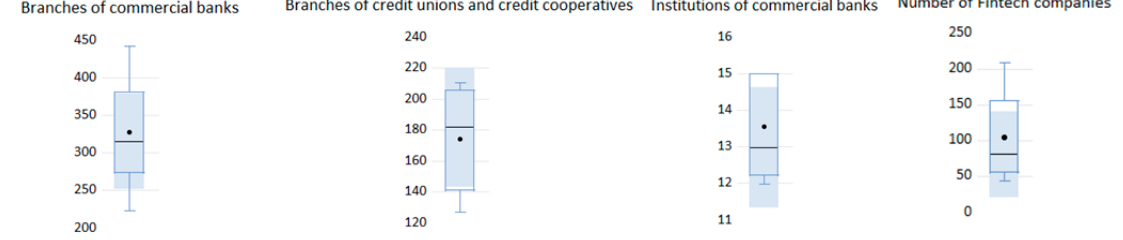
Figure 5. The dynamics of financial institutions in 2013–2019.